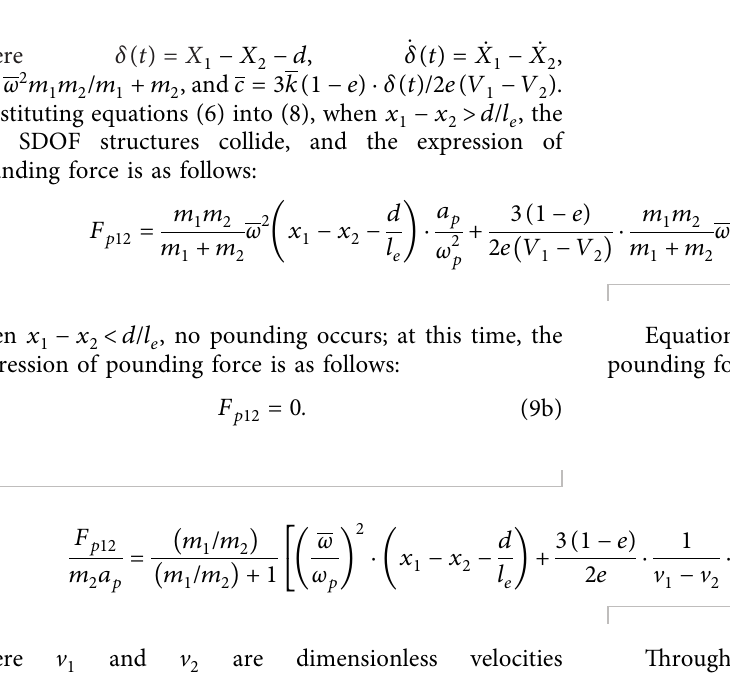
Figure 1: The improved Kelvin analytical